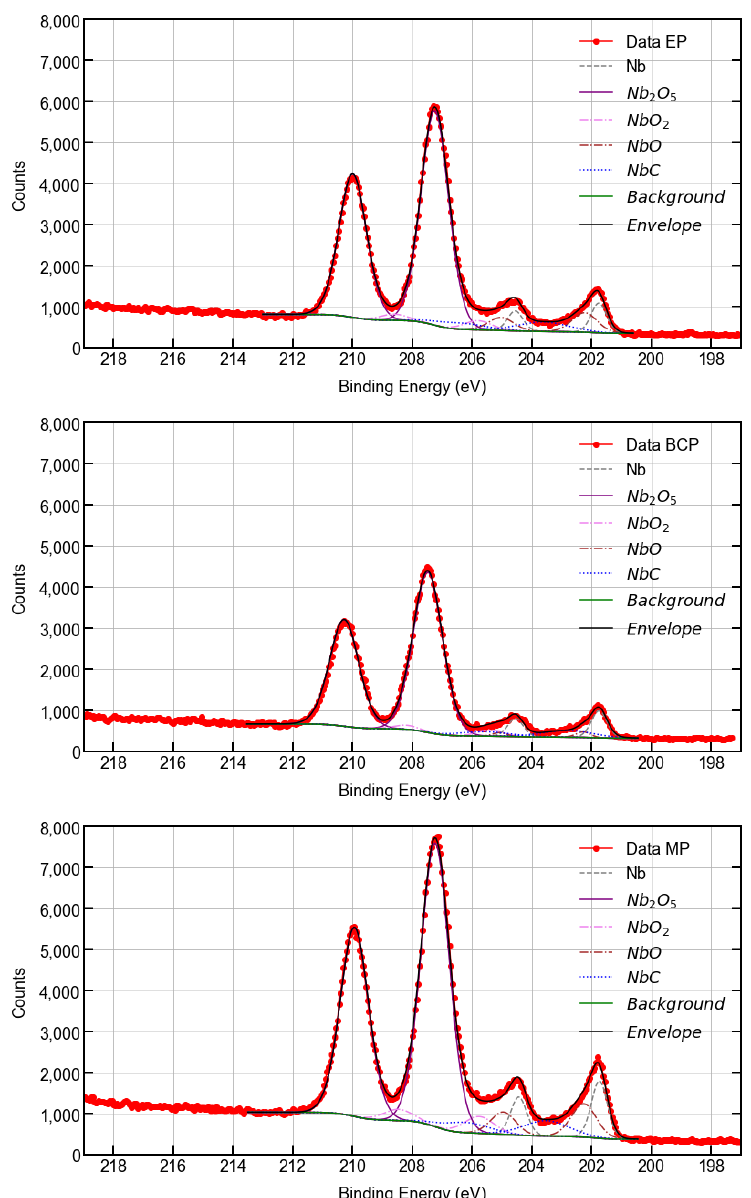
Figure 17. High-resolution XPS spectra for the Nb 3d core peak after different treatments (BCP, EP, and MP).